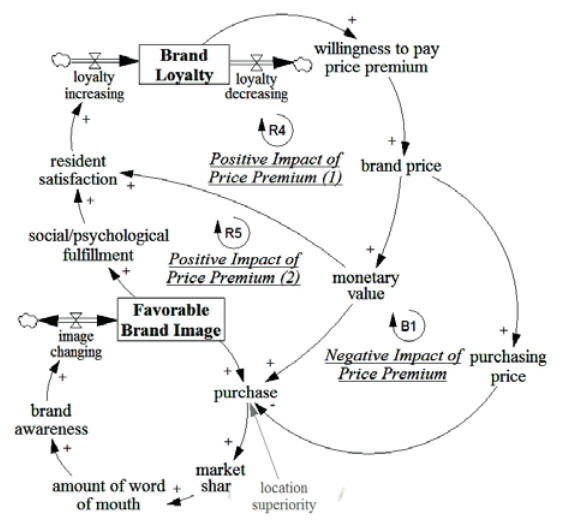
Fig. 6. Role of brand loyalty